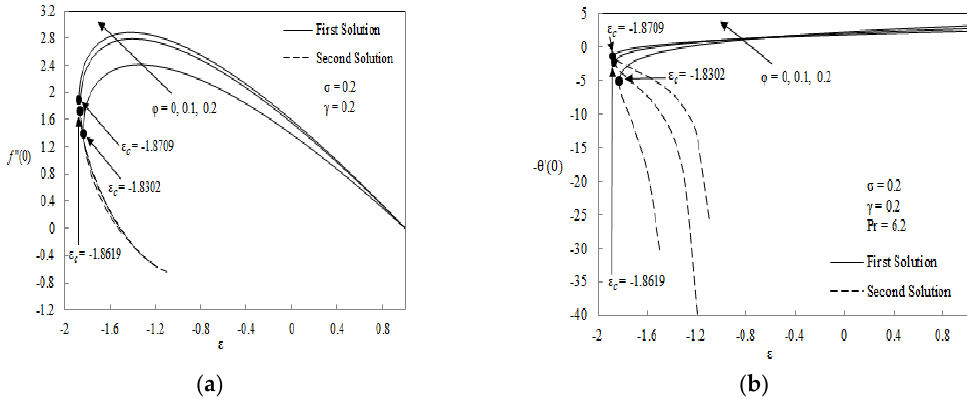
Figure 5. Skin friction f (cid:48)(cid:48) ( 0 ) ( a ) and heat transfer coefficient − θ (cid:48) ( 0 ) ( b ) vs. ε for particular values of ϕ .